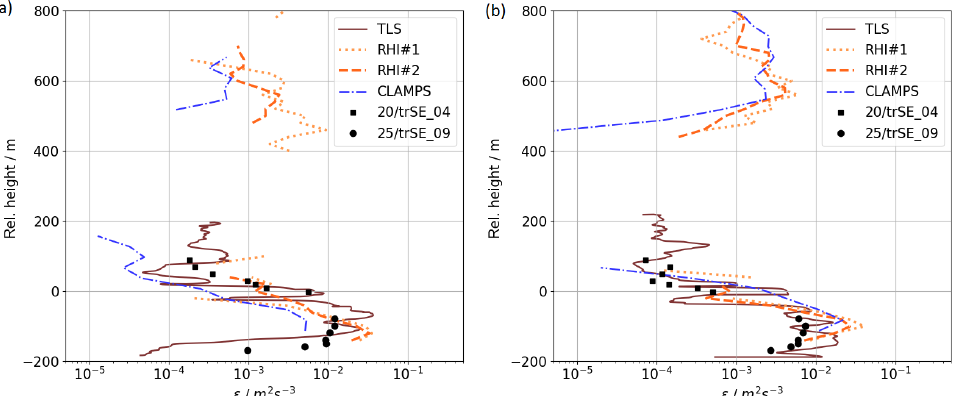
Figure 11. Comparison of average vertical profiles of eddy dissipation rate ε measured by lidar vertical stare, RHI scans, TLS, and sonic anemometers on meteorological towers at 04:00–04:30UTC (a) and at 05:00–05:30UTC (b) .